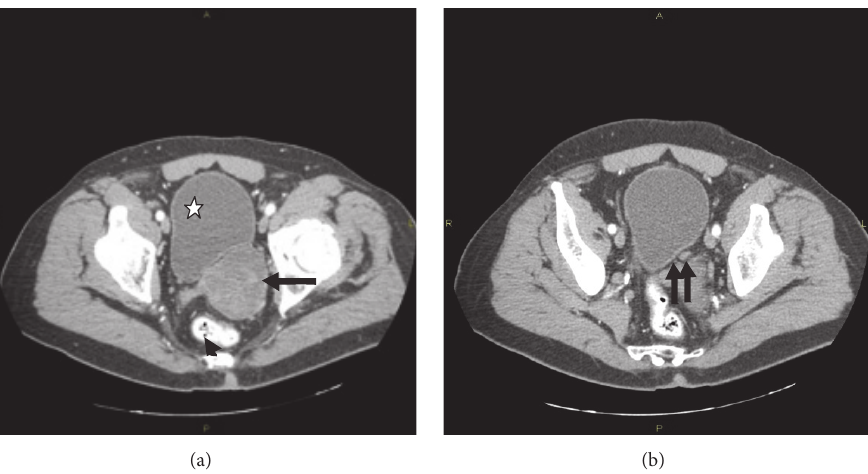
Figure 1: Abdominal/pelvic CT scan image demonstrating (a) a solid, lobed, well-circumscribed mass (arrow) compressing the rectum (arrowhead) and the posterior wall of the urinary bladder (white star) and (b) the distal part of the left ureter (double arrow) between the mass and the bladder